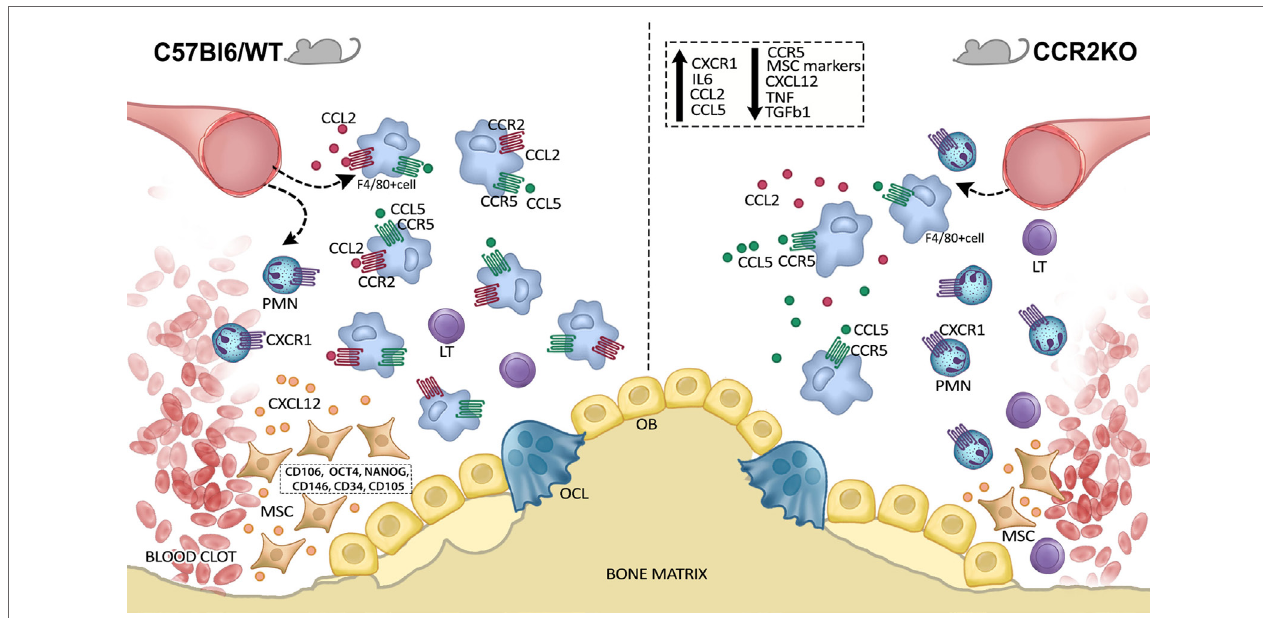
FigUre 8 | Graphical abstract of CCR2 contributions on F4/80 + cell migration along intramembranous bone healing in maxilla. CCR2 contributes to monocytes/ macrophages into alveolar bone injury post tooth extraction, and consequently result in downregulation of mesenchymal stem cell (MSC) markers and growth factors at the healing sites. On the other hand, the migration of the F4/80 + cells in CCR2KO mice it is enough to support the proper healing, in a scenario that can involve compensatory immunological